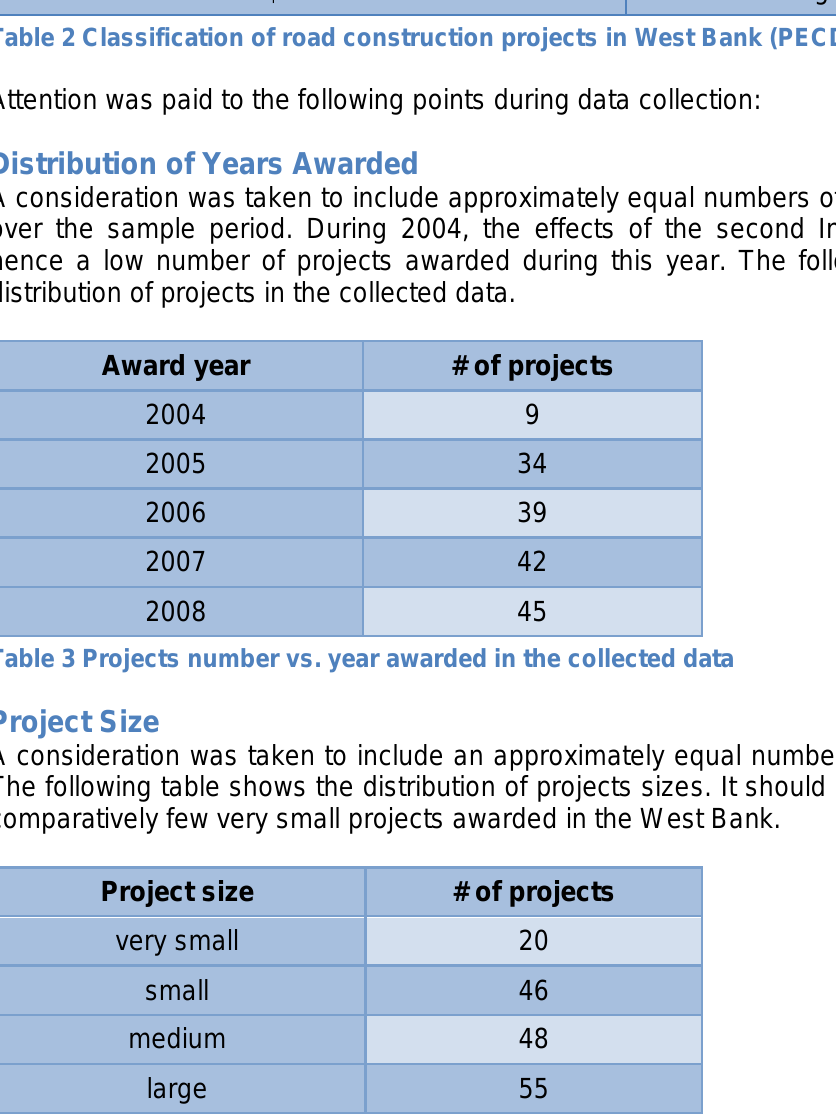
Table 4 Projects distribution based on